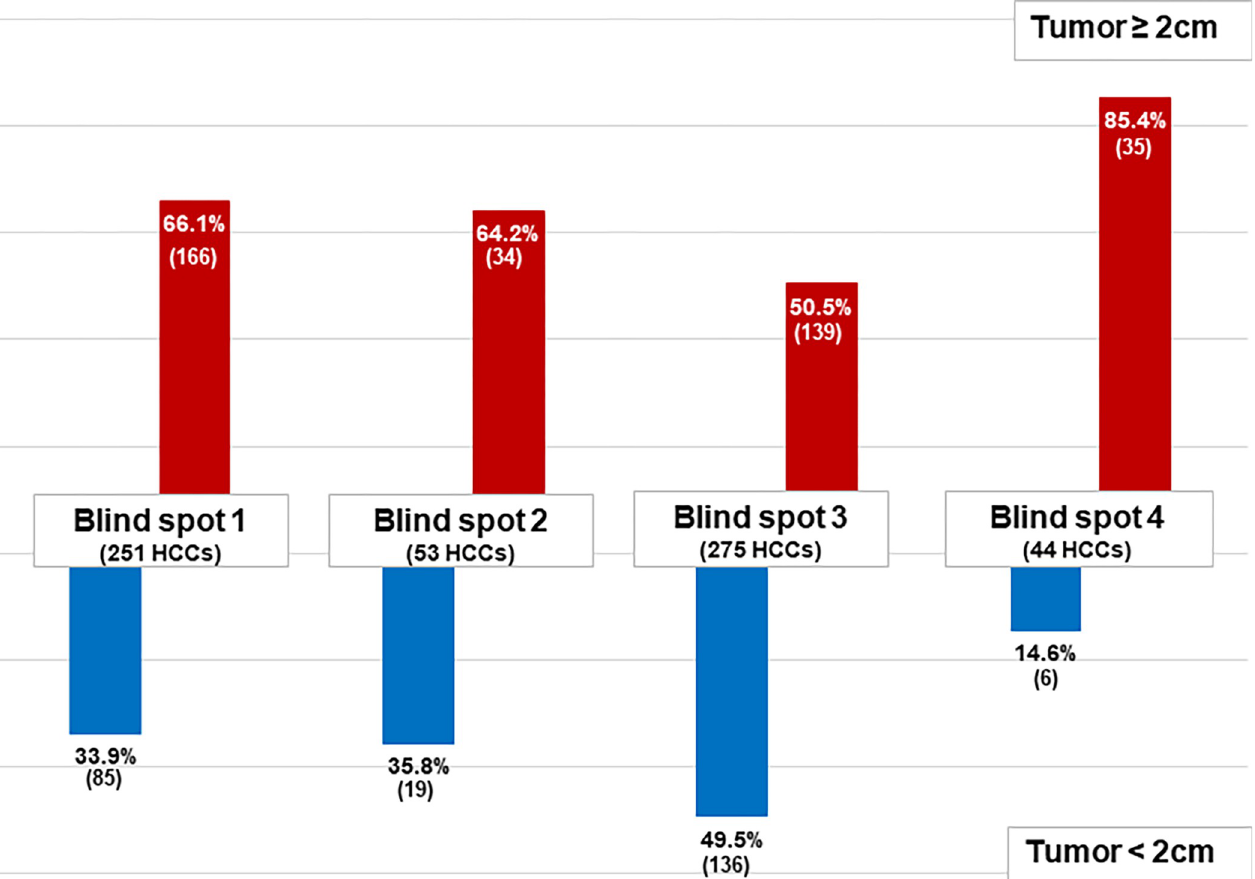
Fig 3. Comparison of the size distribution of HCC in blind spots of the total study population. HCC, hepatocellular carcinoma; US, ultrasonography; � Definition of blind spots: hepatic dome (blind spot 1), caudate lobe or around the inferior vena cava (blind spot 2), < 1 cm beneath the ribs (blind spot 3), and surface of the left lateral segment (blind spot